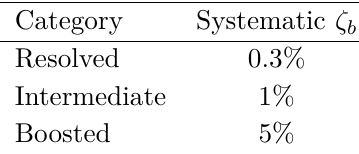
Table 6. The nominal relative systematic uncertainties on the background estimate ζ b assumed when performing the χ 2 analysis for the different analysis